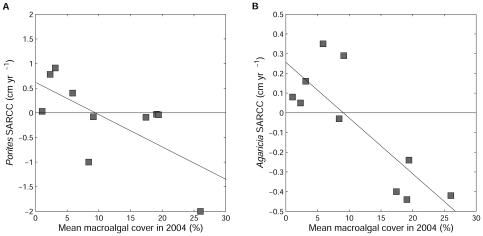
Effect of macroalgal cover on the size-adjusted rate of change of cover (SARCC).Panels show relationships for SARCC of Porites astreoides (A) and Agaricia agaricites (B) between 2004 and 2007 for 10 sites in the Exumas Cays, Bahamas. The four reserve sites had the lowest macroalgal cover.